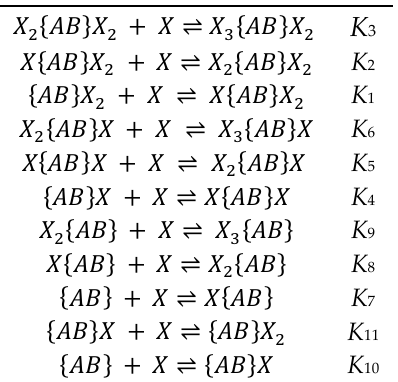
Table 1. Equilibria of an X m { AB } X n system with m = 0, 1, 2, 3 and n = 0, 1, 2.